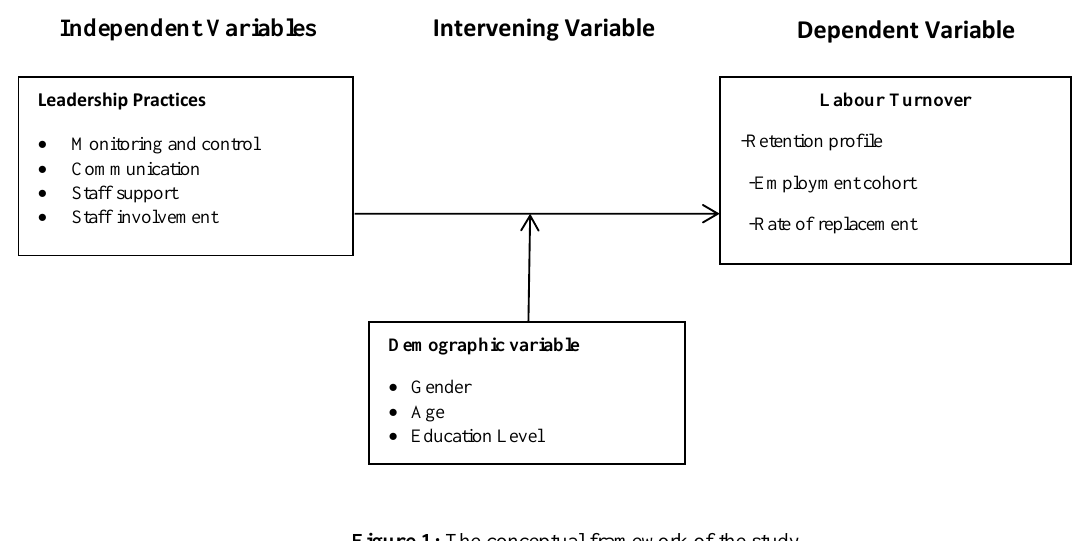
Figure 1: The conceptual framework of the